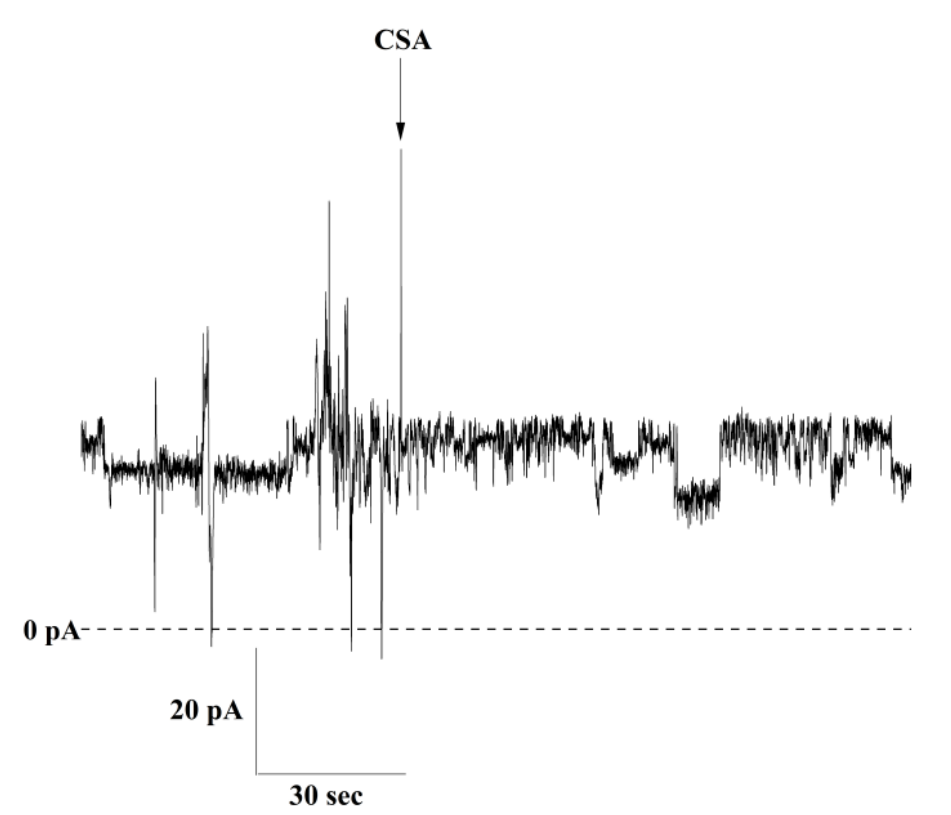
Figure 3. Effect of PTP inhibitor CSA. Ion current trace of the c subunit preincubated with CypD showing channel activity before and after addition of CSA (20 µM).